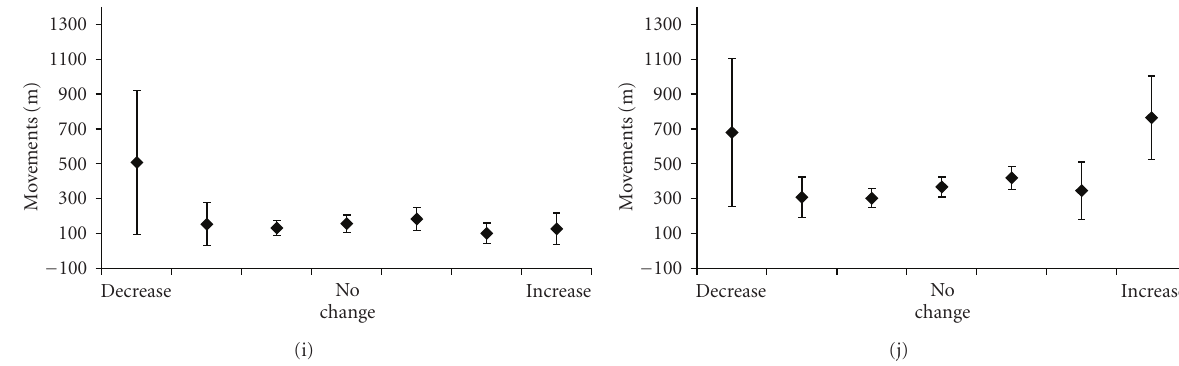
Figure 4: Plots of the e ff ects of changes in weather within hour from day to day on hourly deer movements. Temperature influenced movements of females during spring at 0100 hr (a) F 5,368 = 2.41, P = . 036) and male during winter at 1300 hours ((b) F 6,227 = 4.1, P < . 001). Males movements were a ff ected by relative humidity during spring at 0100 hours ((c) F 5,341 = 2.56, P = . 027) and 1300 hours ((d) F 6,244 = 3.78, P = . 001). Precipitation influenced female movements at 1300 hours during summer ((e) F 6,225 = 3.35, P = . 004). Pressure a ff ected movements of females during spring at 0100 hours ((f) F 4,370 = 2.58, P = . 037) and summer at 0200 hours ((g) F 2,230 = 3.12, P = . 046) and male movements during winter at 1300 hours ((h) F 5,225 = 4.82, P < . 001). Male movements during winter were a ff ected by wind speed at 1300 hours ((i) F 6,225 = 3.35, P = . 004) and 1800 hours ((j) F 6,303 = 3.01, P = .